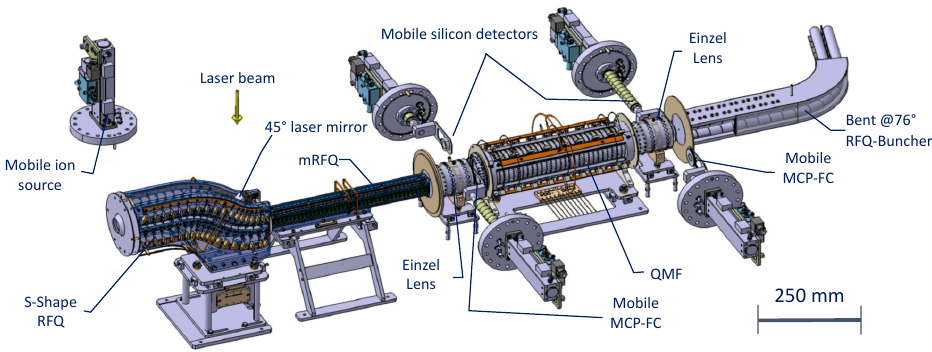
Figure 2. Full S 3 -LEB ion guide layout. From left to right: mobile ion source, SRFQ, mRFQ, QMS and RFQ cb . See text for